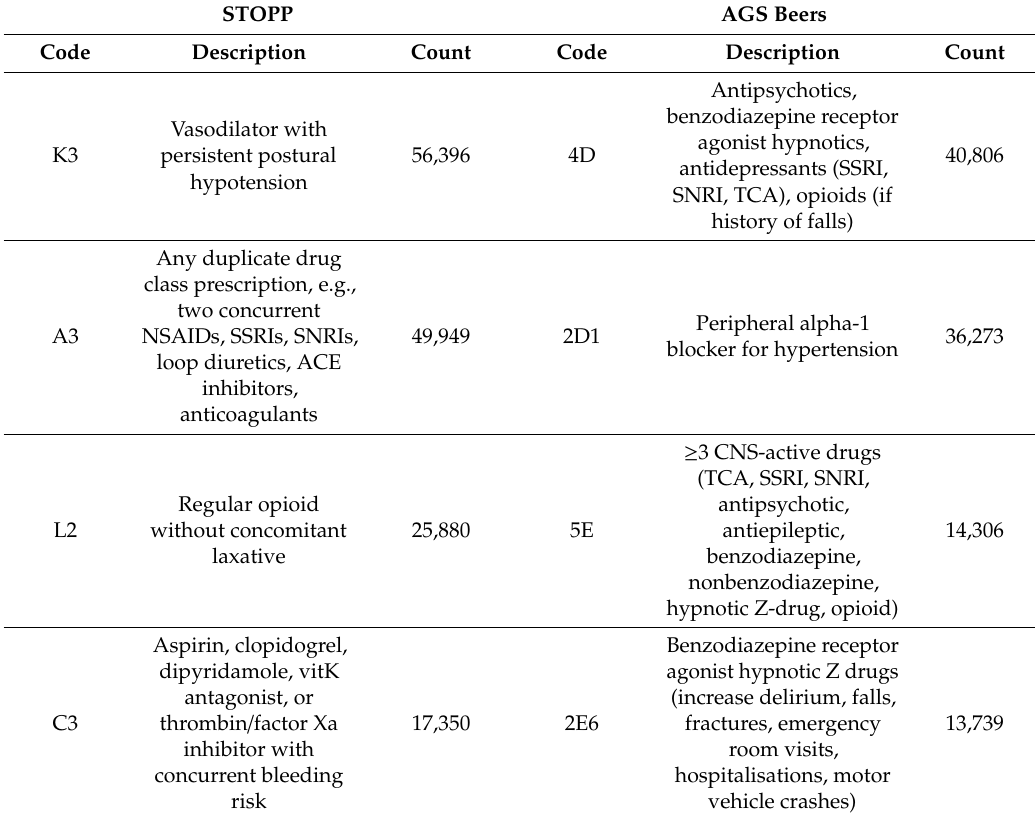
Table 2. Most frequent STOPP and American Geriatric Society (AGS) Beers PIMs, START PPO omissions, and PPO prescriptions with counts of 100 or more